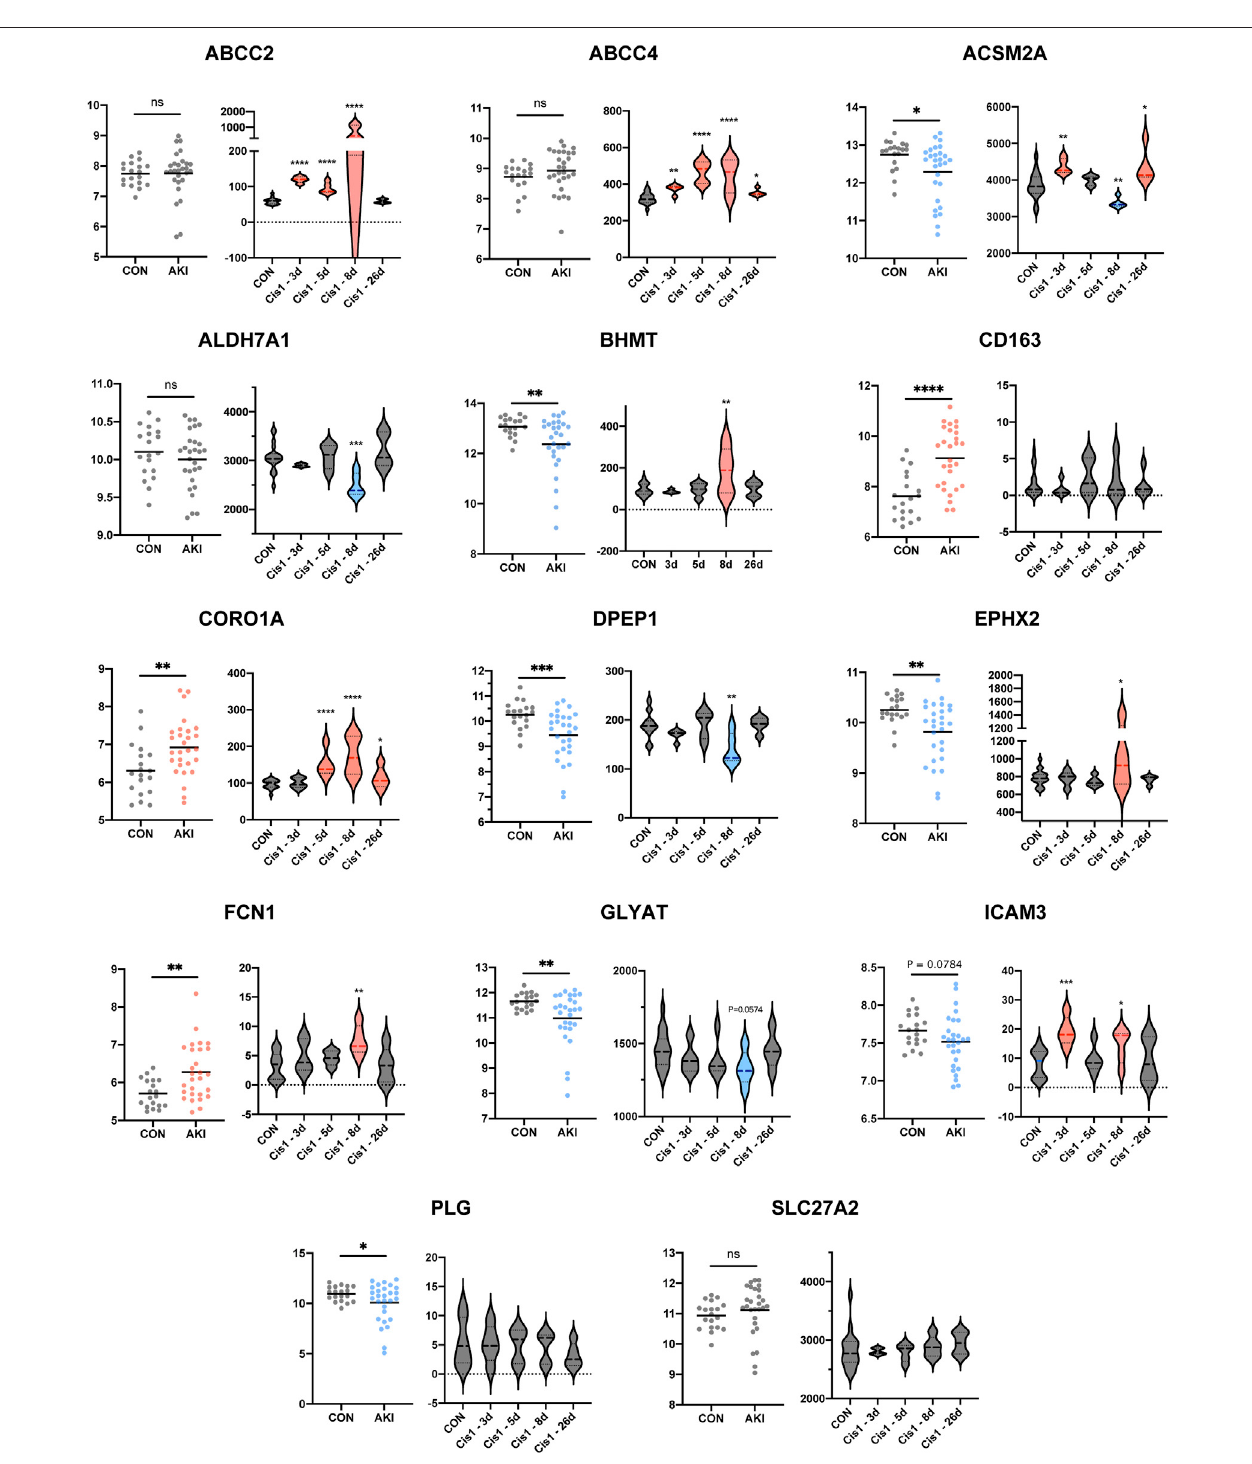
FIGURE 7 | Extensive new dataset validation of key genes based on GSE30718 and GSE85957. Histogram plot shows expression level between control and AKI groups based on human datasets GSE30718 (left). Different expressions along with time course are depicted in boxplots (right). * p < 0.05, ** p < 0.01, *** p < 0.001, and **** p < 0.0001 vs. the control group.